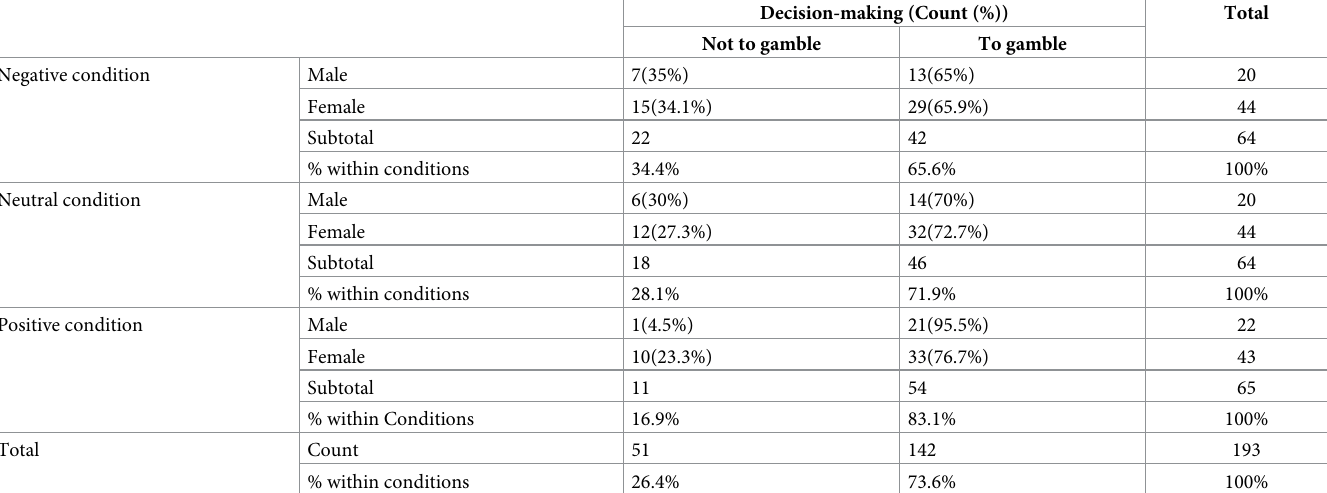
Table 4. Descriptive statistics for decision-making for a real gambling game among different fortune telling conditions in Study 3.